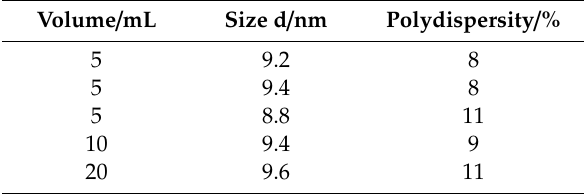
Table 3. Volume-independent nanoparticle size. [Ni] 50 mmol /